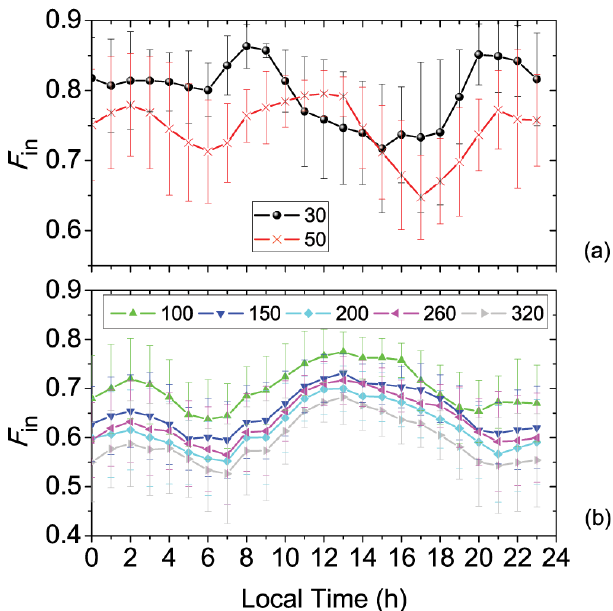
Fig. 3. Average diurnal variation of F in at different size bins (30, 50, 100, 150, 200, 260, and 320nm). Symbols represent arith- metic mean values and error bars represent the standard deviation.